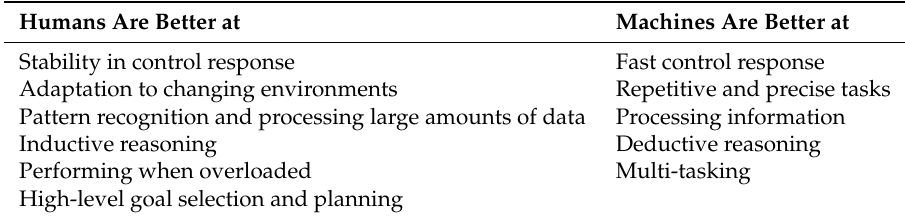
Table 1. Human-in-the-loop trade-offs